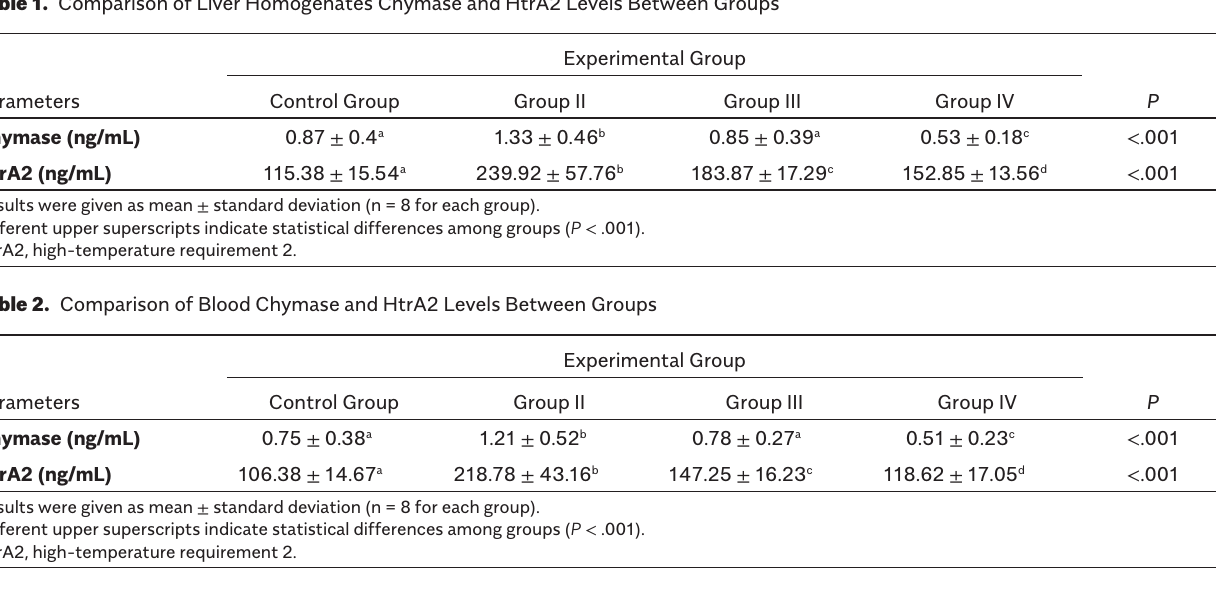
Table 1. Comparison of Liver Homogenates Chymase and HtrA2 Levels Between Groups